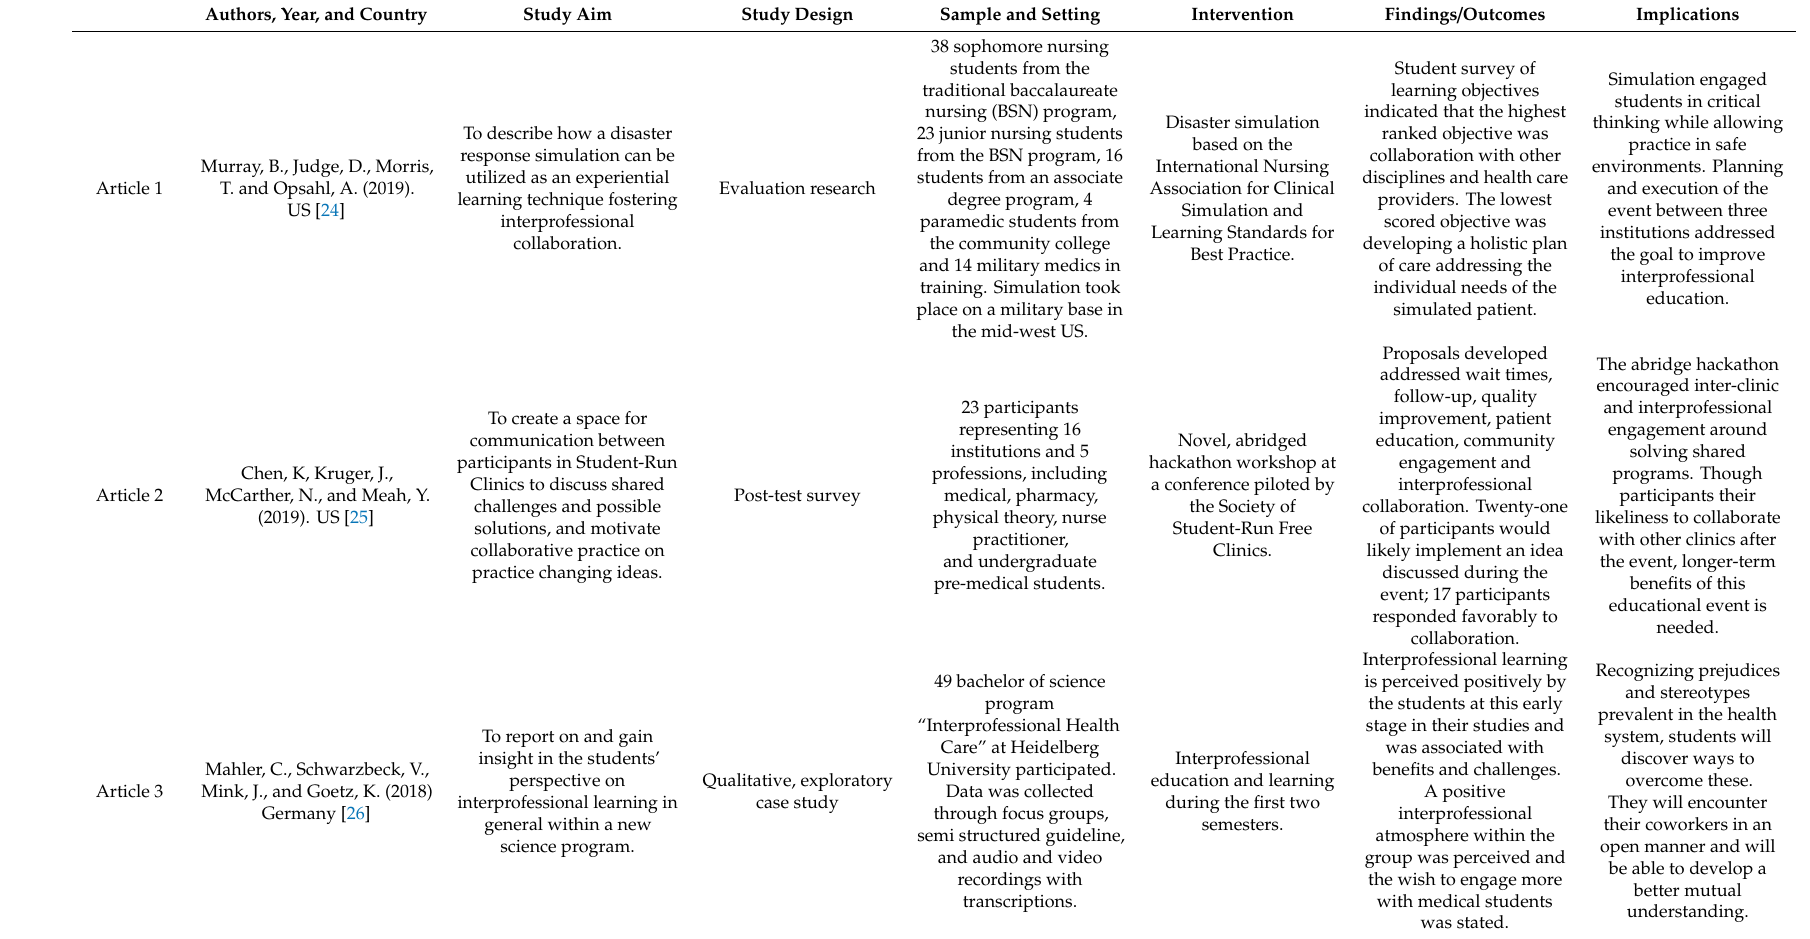
Table 1. Articles Selected for Inclusion in the Integrative